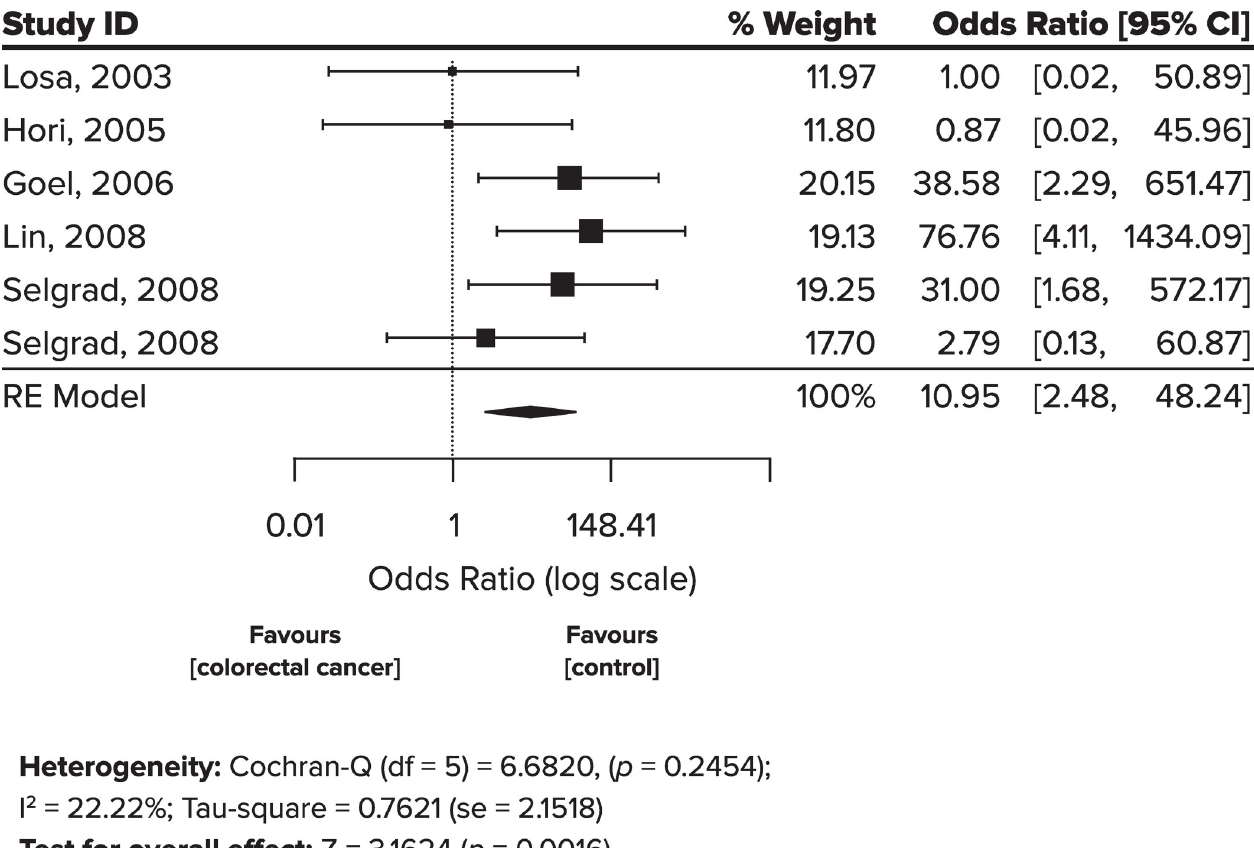
Fig 2. Effect of JCV T-antigen protein expression on the risk of neoplasm development (vs. any control tissue). Meta-analysis (RE = random-effects model) for the association between JCV T-antigen protein expression and the risk of neoplasm development in CRC and adenoma cases vs. controls.